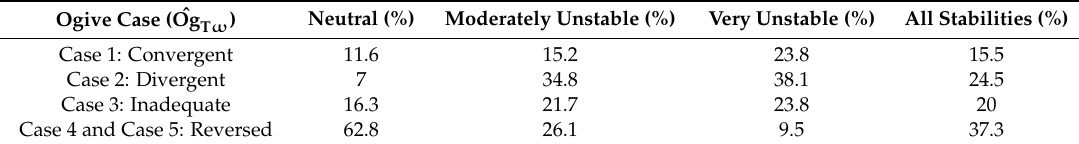
Table 3. Classification fractions of the Ogives for sensible heat flux (corresponding to upper panels in Figure 2). The numbers are the fraction of Ogives in a given category (column) under the given classification (row).